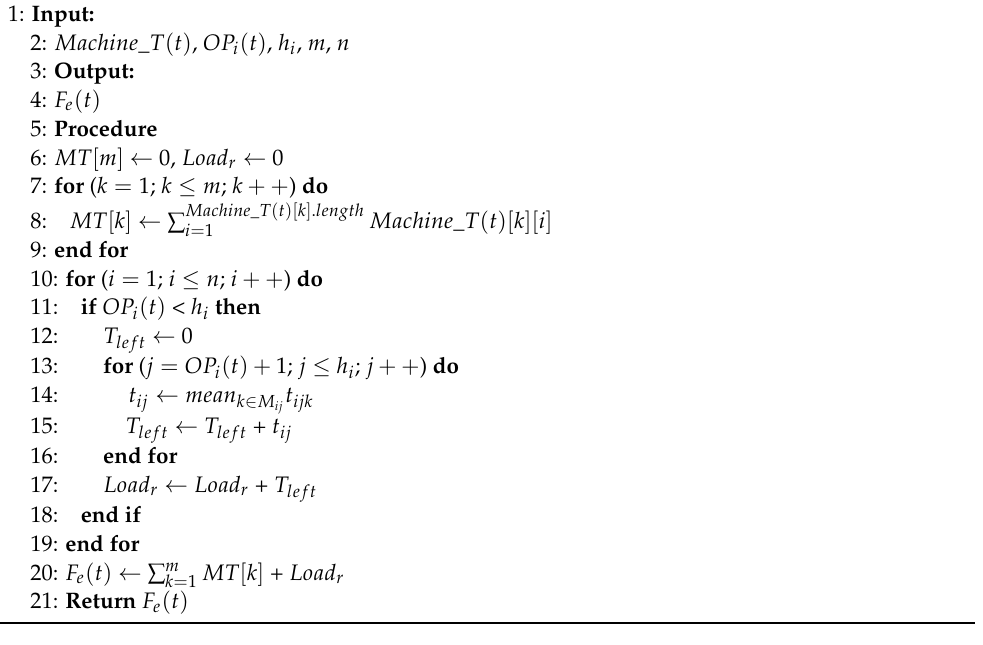
Algorithm 1 Procedure of calculating the estimated total machine load F e ( t